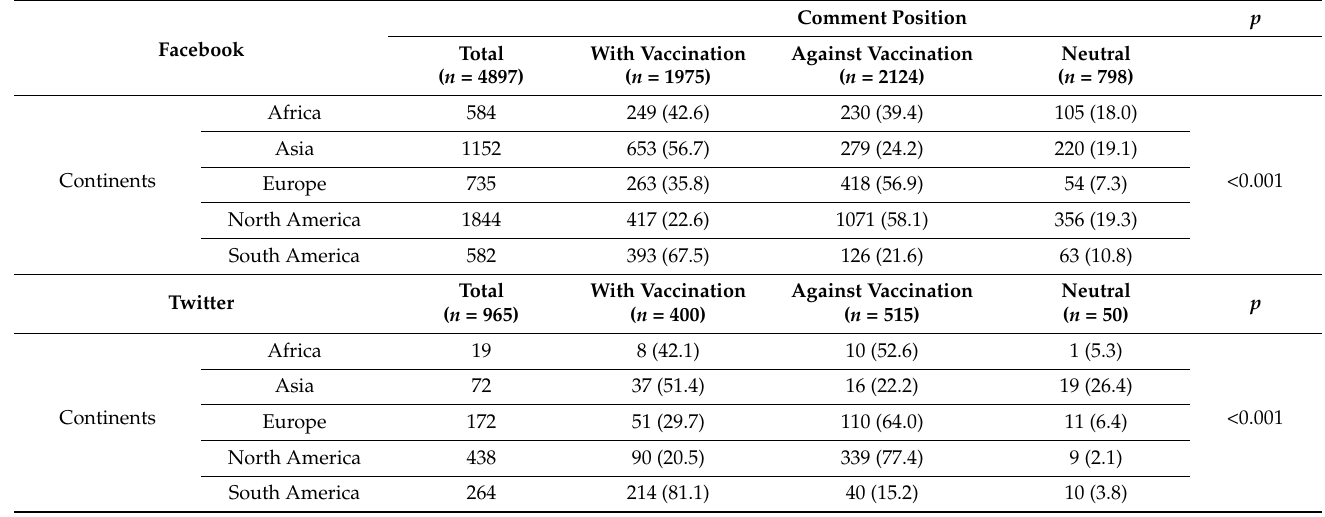
Table 2. Continent-position toward COVID-19